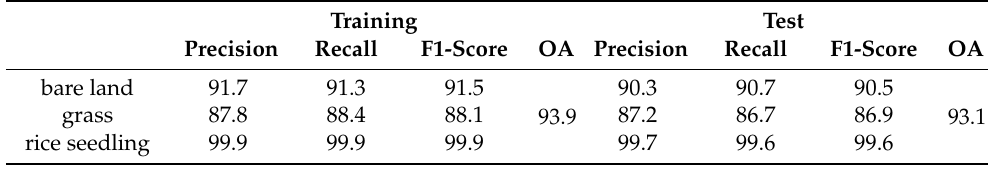
Table 5. HOG-SVM training and test evaluation metrics.